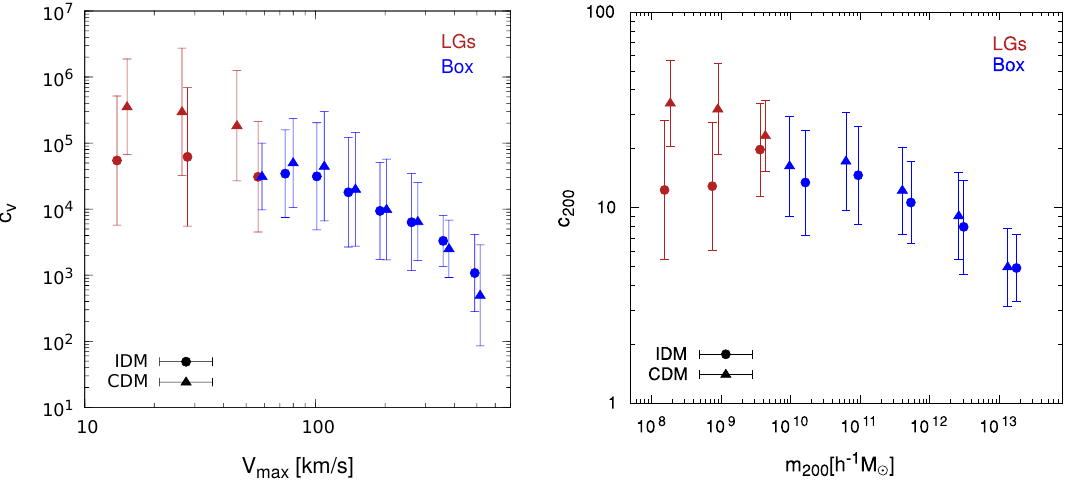
Figure 2. Median subhalo concentrations and 1 σ errors as found in our set of simulations, Box (blue) and LGs (red), at z = 0. The circle symbols represent the results from the IDM simulations, whereas the triangle symbols correspond to the CDM results. ( a ) Left panel: the median c V as a function of V max . ( b ) Right panel: c 200 as a function of m 200 as obtained using Equations (6) and (7) for every subhalo in the simulations.